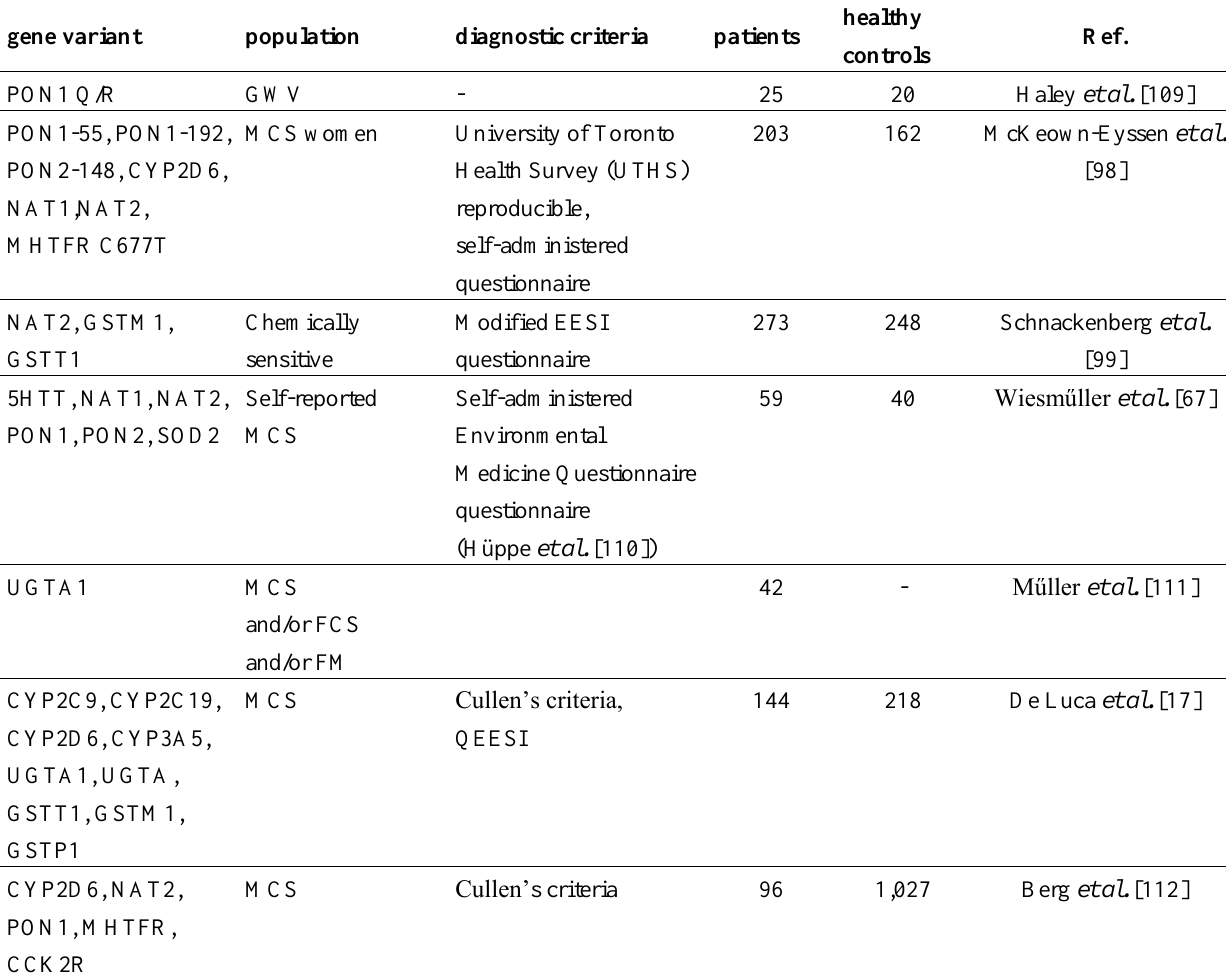
Table 1. Main gene variants studied in MCS